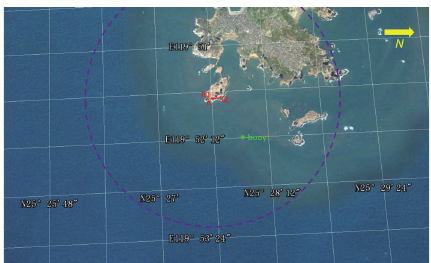
Figure 1: Map of the experimental site. The three red dots are the positions of X-band marine radars with HH and VV polarizations (R1 and R2) and the anemometer (A). The purple dashed circle denotes the observation area of the radars. The green star denotes thelocationofthebuoy.Theyellowarrowpointstonorth.Thecolors of ocean water show the changes of bathymetry.